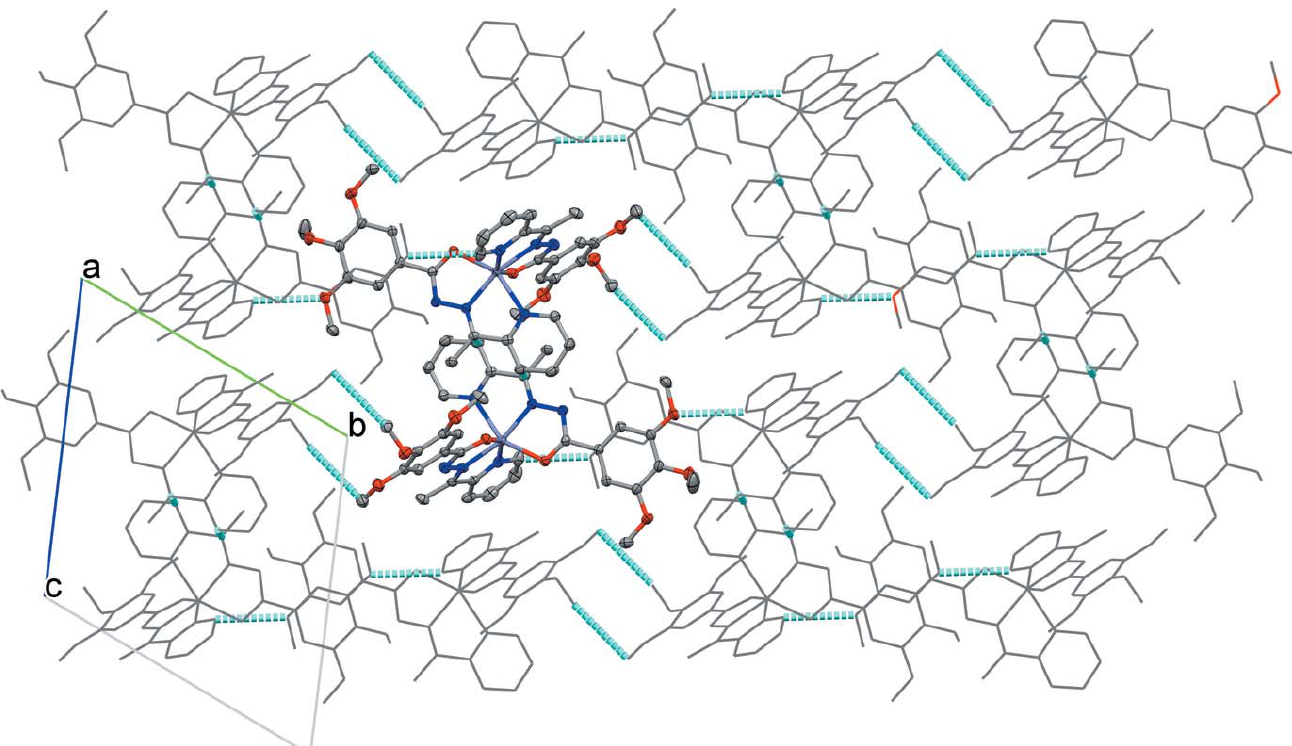
Figure 2 The packing of molecules, showing as dashed lines the interactions below the sum of the van der Waals radii. The supramolecular dimer is also